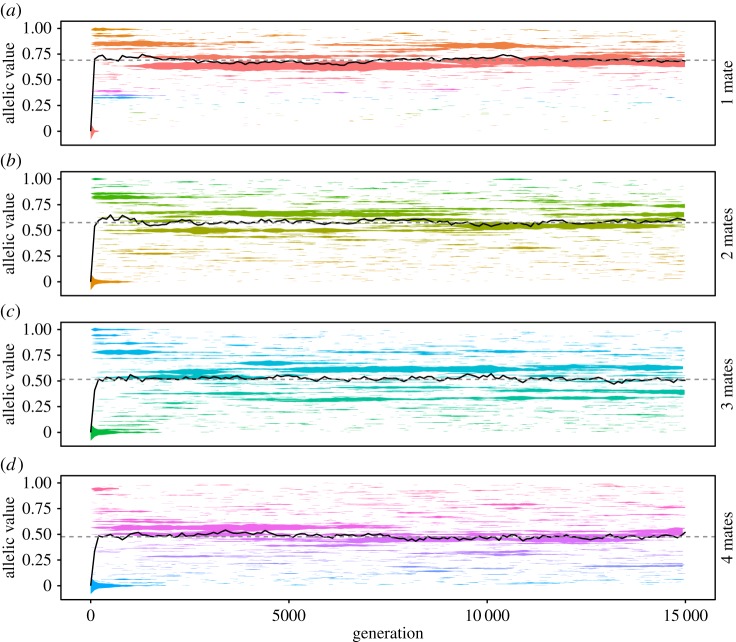
Predicted evolutionarily stable states for worker sterility are valid even assuming a ‘saltationist’ model of genetic mutation in which newly arising alleles take a random penetrance uniformly distributed between 0 and 1. Separate plots show increasing levels of promiscuity, from n=1 mate (a) to n=4 mates (d). Within a plot, the predicted ESS for sterility, z*, is shown as a dashed line; the average worker sterility in a given generation is shown as a solid line; and coloured ribbons show the alleles present in the population, with the width of each ribbon giving the allele’s relative frequency and the vertical position of the ribbon giving the allele’s penetrance. We assume that sterility is controlled by a single locus at which allelic effects are averaged together, but results are equivalent for fully dominant or fully recessive alleles, or when we assume that sterility is controlled by multiple loci, each with different magnitudes of allelic effect. Alleles which persist for fewer than 100 generations are not shown in this figure. We assume that rz=1+z−0.5z2 and pz=0.2+0.8z, which yields z*=0.690 when n=1; z*=0.576 when n=2; z*=0.515 when n=3; and z*=0.476 when n=4.